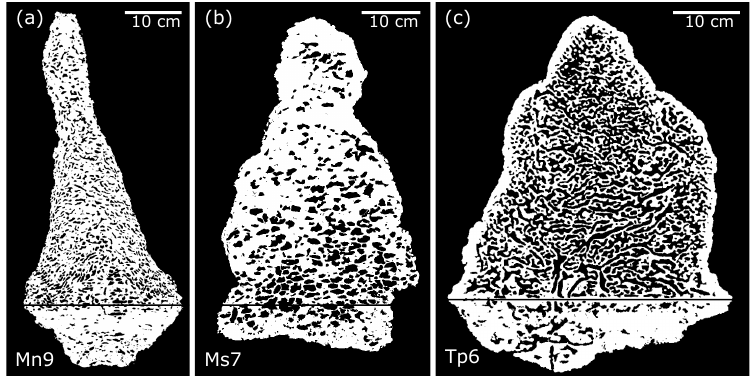
Figure 4. Binary image of a single CT slice in xz direction for each investigated species: (a) Microcerotermes nervosus , (b) Macrognathoter- mes sunteri , (c) Tumulitermes pastinator . The thin black line approximately indicates the soil surface. Table 2. Mean physical and morphological parameters of TMs from three termite species. Errors represent 95% confidence intervals; significance levels of the one-way ANOVA to test differences between species are indicated with ∗ . Microcerotermes nervosus Macrognathotermes sunteri Tumulitermes pastinator PG method n = 10 n =